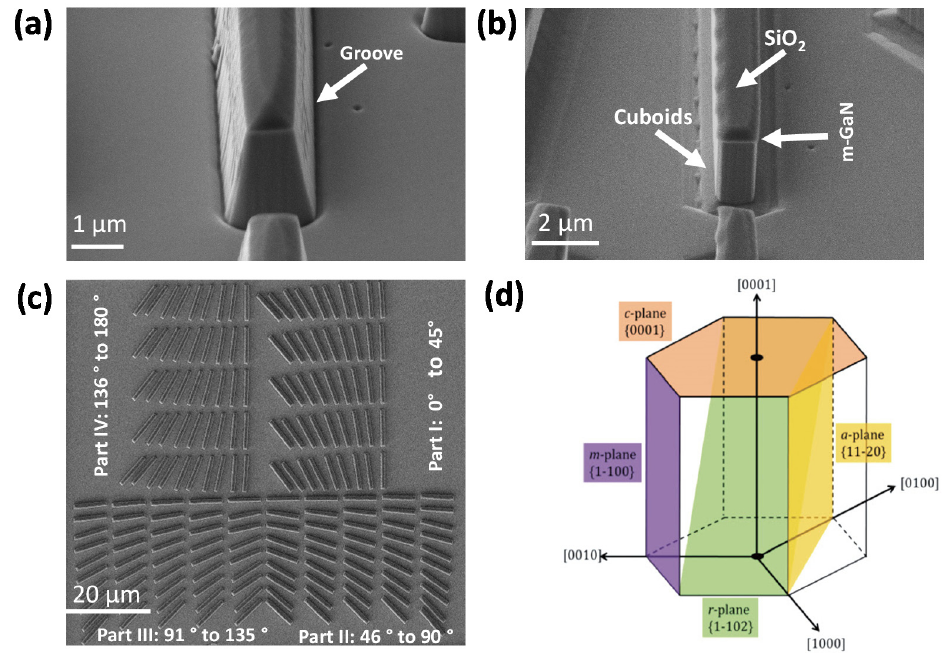
Figure 2. SEM images of fingers after GaN etching;( a ) bird eye view of finger after dry etching; ( b ) bird eye view of finger after wet etching with TMAH solution; ( c ) top view of an ensemble of fingers for orientation between 0° and 180°; ( d ) GaN crystallographic planes [33].